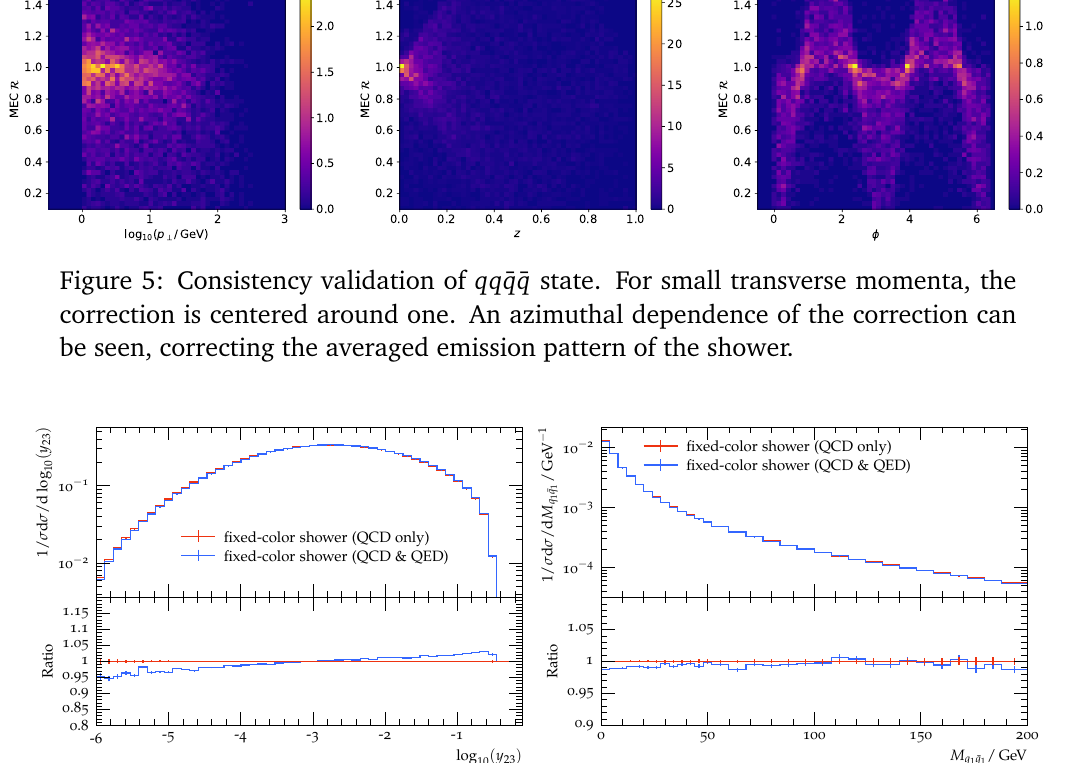
Figure 6: Comparison of pure QCD shower evolution and shower evolution with photon emissions enabled. The left plot shows the Durham jet clustering scale for the emission of one gluon or photon. The inclusion of photon emissions shifts the spectrum towards higher scales, as expected. The right plot shows the invariant mass of the pair of less energetic quark and anti-quark for the qq ¯ q ¯ q state. The effect of the QED emission alone is very small, just leading to a light depletion of very small